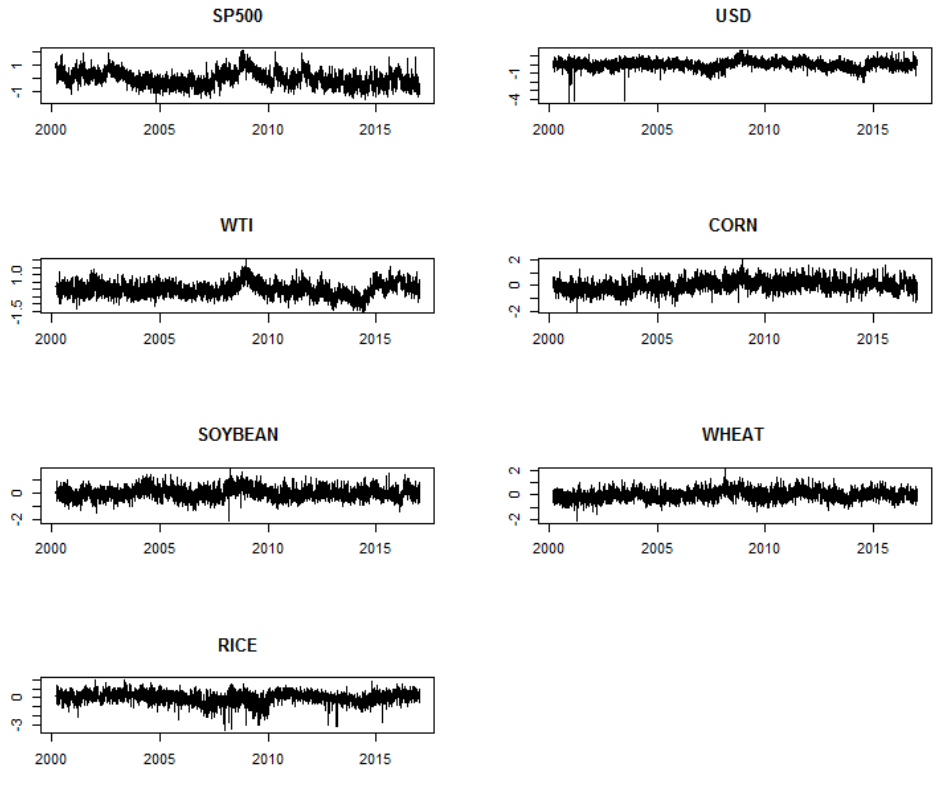
Figure 1: Seasonally adjusted series of log range volatility: January 4, 2000–April 1,